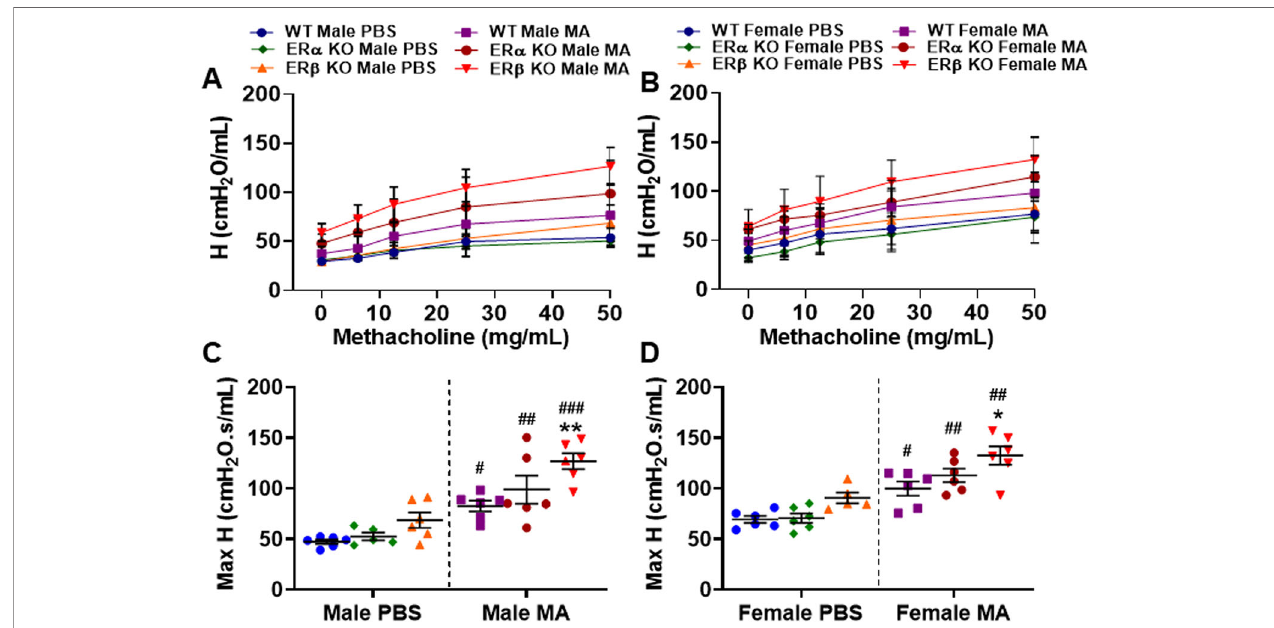
FIGURE 6 | Effect of ER signaling on tissue elasticity (H) in the lungs of (A) male and (B) female mice (WT vs. ER a KO vs. ER b KO) exposed to PBS and MA. Max H was used to compare WT, ER a KO and ER b KO in (C) male and (D) female mice exposed to PBS and MA. Data represented as mean ± SEM of at least 5-6 mice per treatment group; # p < 0.05, ## p < 0.01, ### p < 0.001 vs. PBS of respective groups (MA effect) and *p < 0.05, **p < 0.01 vs. WT of PBS/MA (ER speci fi c KO